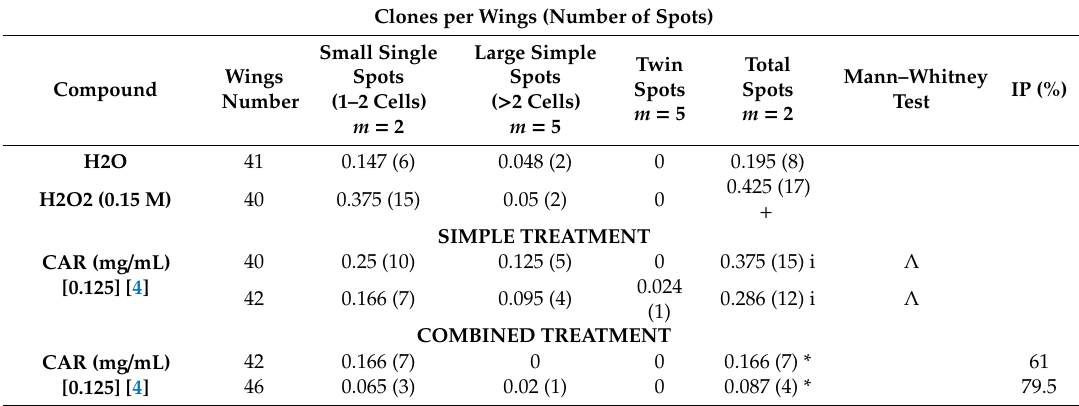
Table 3. Genotoxicity and Antigenotoxicity assays of CAR in D. melanogaster .